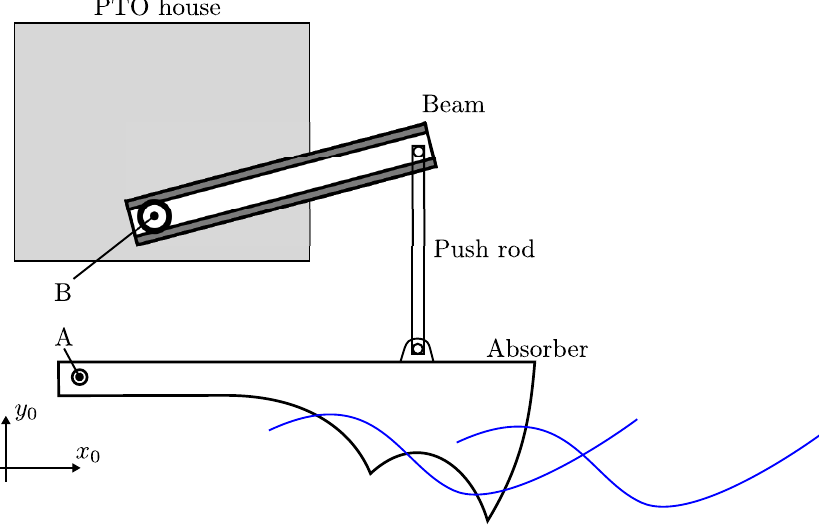
Figure 1. Illustration of the FPP wave energy